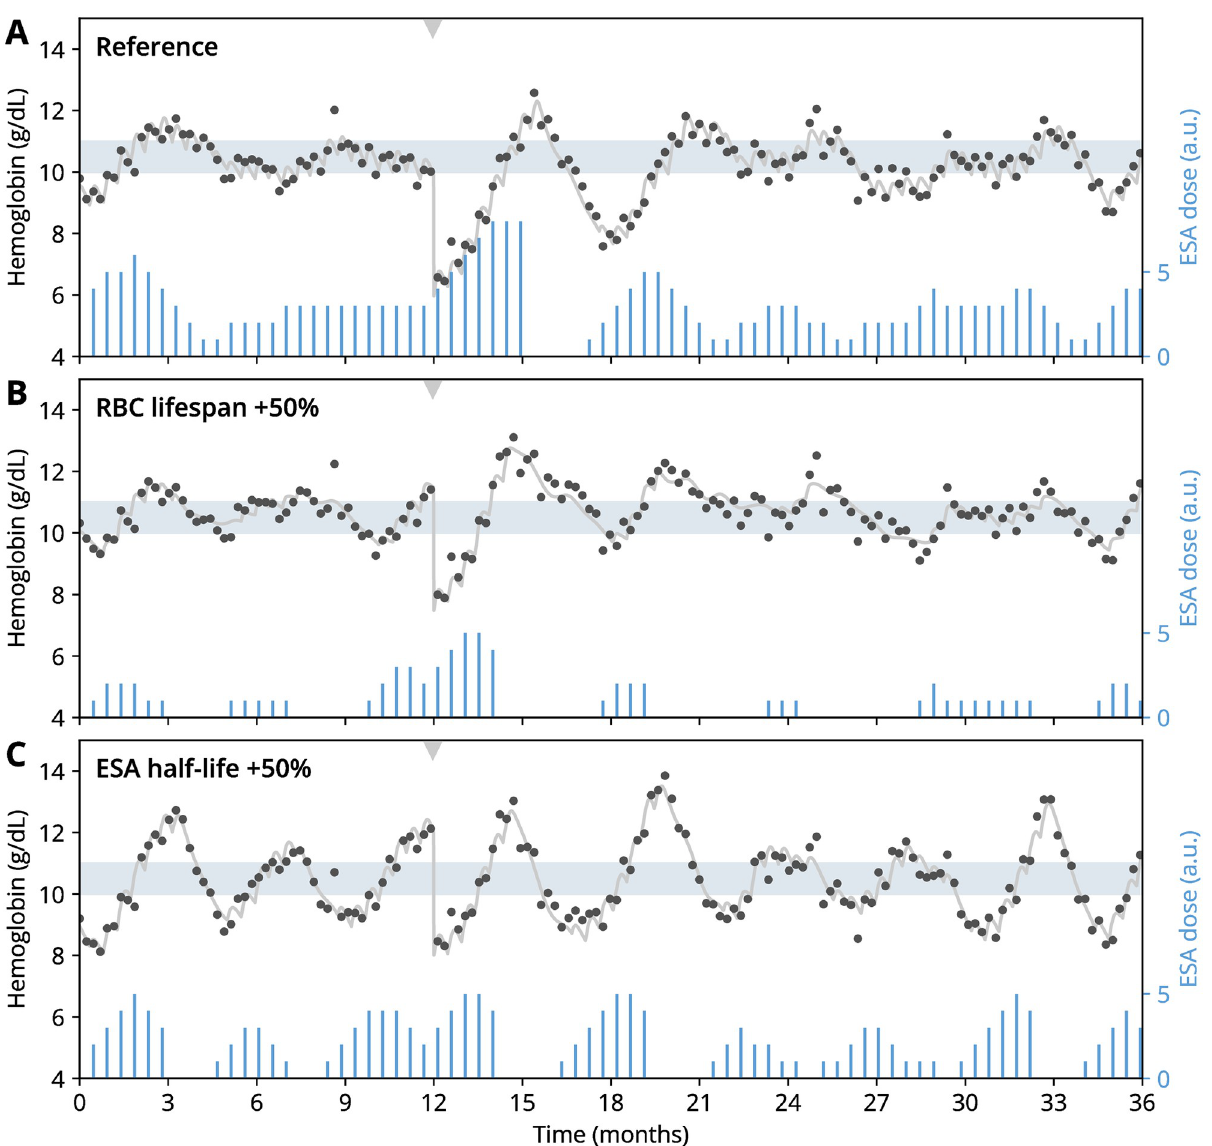
Fig 7. Transient cycling can be induced by events unrelated to treatment such as sudden blood loss. (A–C) Simulated bleeding scenarios where hemoglobin levels have been instantly reduced by 4 g/dL at 12 months (gray arrow). Parameter values for the reference scenario (panel A) are provided in Table 1. Parameter changes in panels B and C as indicated in the plot. All display conventions as in Fig